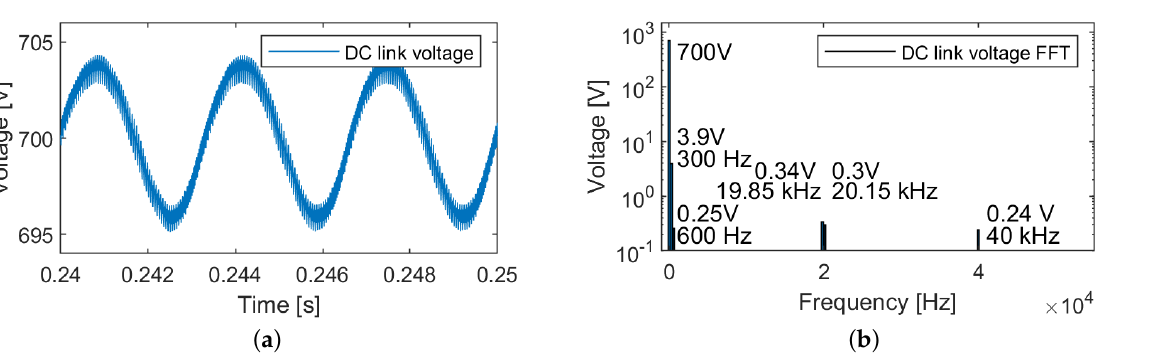
Figure 14. Three-phase three-level neutral point clamped rectifier simulation results. ( a ) DC link voltage. ( b ) DC link voltage harmonic analysis.